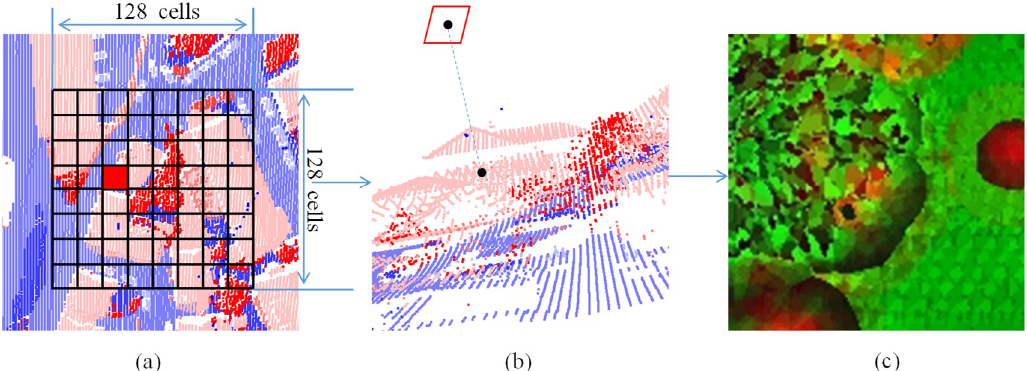
Figure 2. The steps of feature image generation: ( a ) Set up the square window and find the cell. ( b ) Search for the nearest point and assign the value to the cell. ( c ) Generate the feature image.